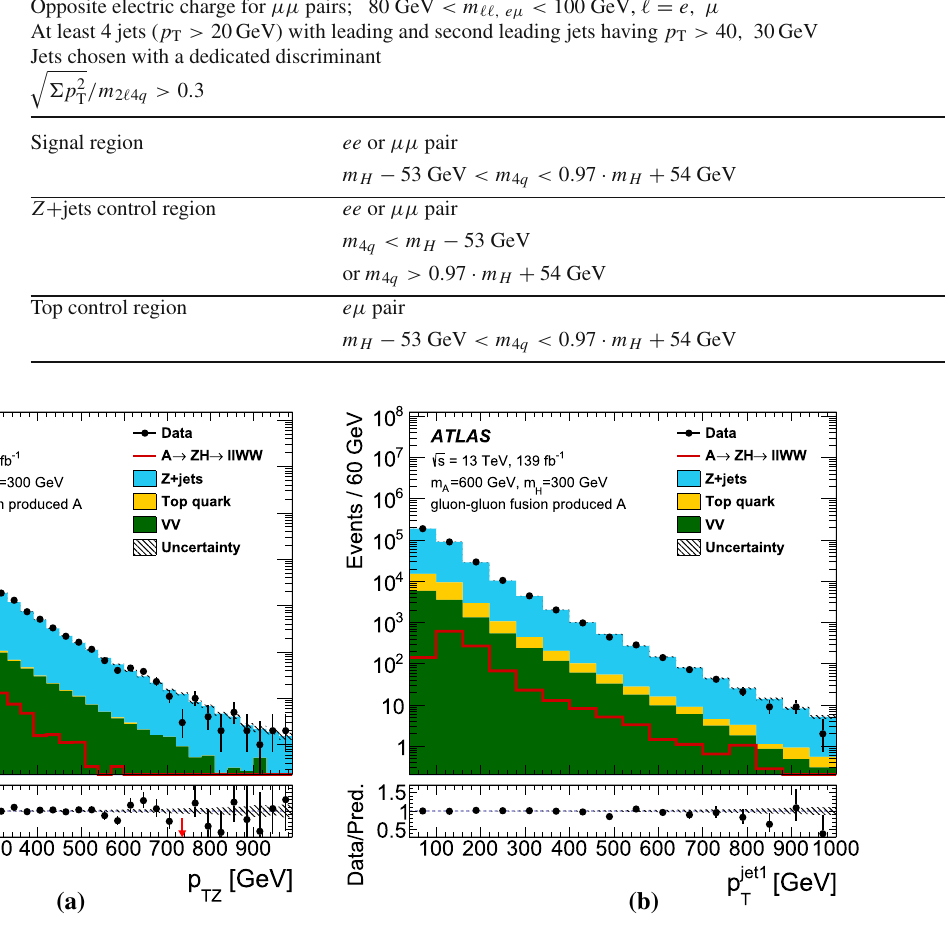
Fig. 5 The distributions of a the p T of the Z boson candidates and b the leading jet’s p T in the (cid:6)(cid:6) WW channel. The events are required to satisfy all the signal region criteria with the exception of the m 4 q The top-quark background shape is taken from